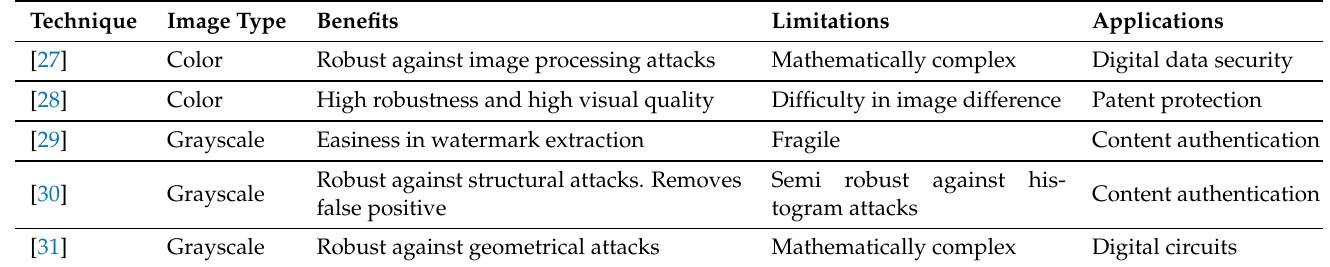
Table 1. Analytical comparison of existing